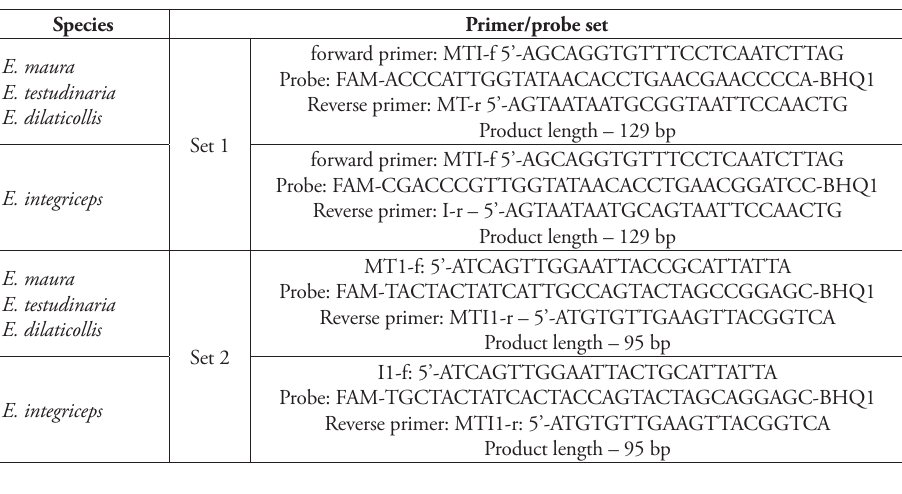
Table 5. Restriction enzymes for PCR-RFLP and expected lengths of the 585 bp COI fragment cleavage